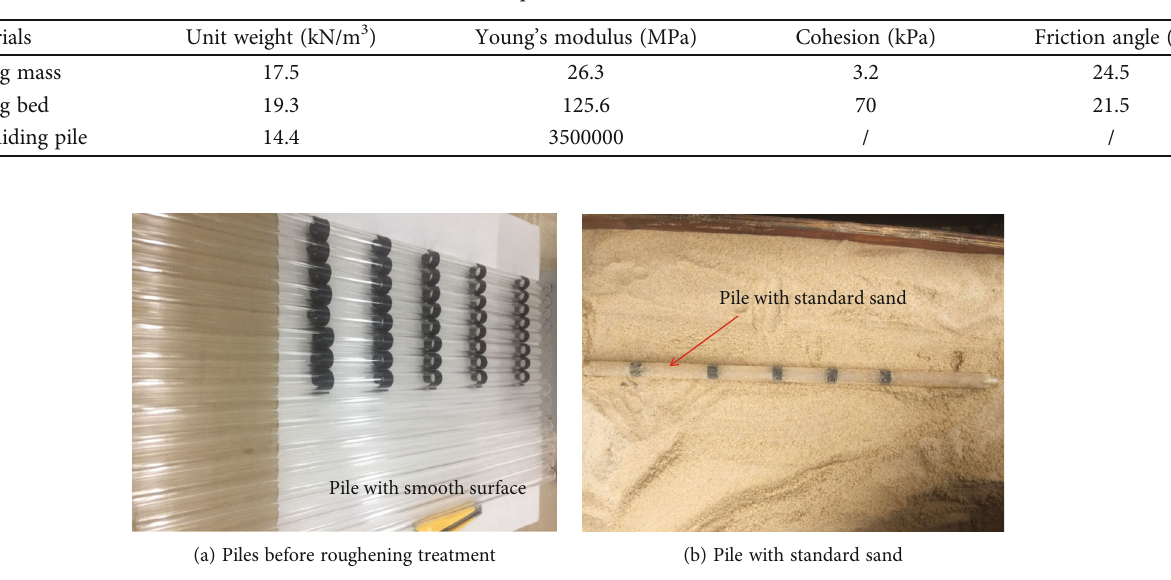
Figure 4: Roughening treatment of the model pile.